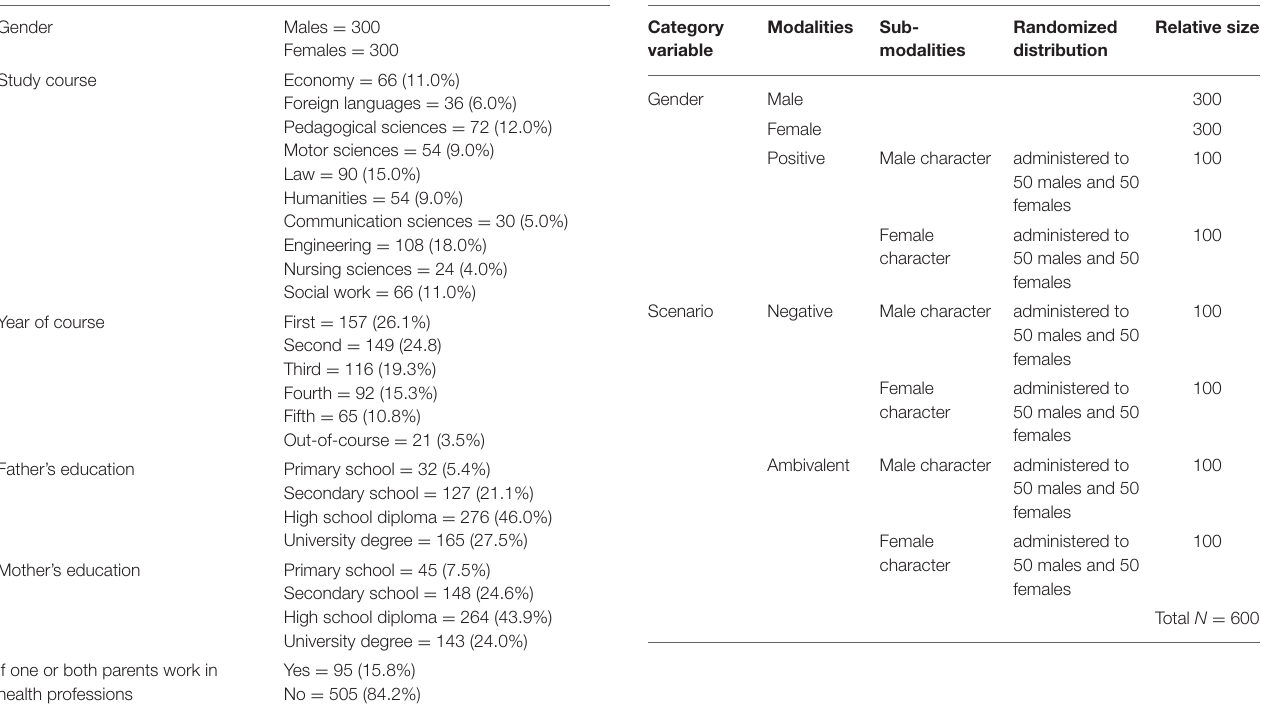
TABLE 2 | Research sample